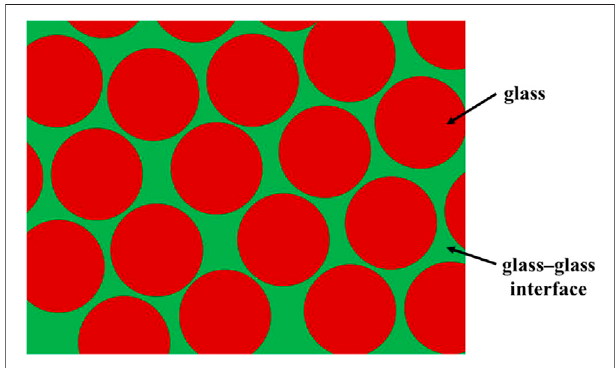
FIGURE3| Schematicpresentationofthenanostructuredmetallicglass (nanoglass) features containing glassy core and glass-glass interface regions.